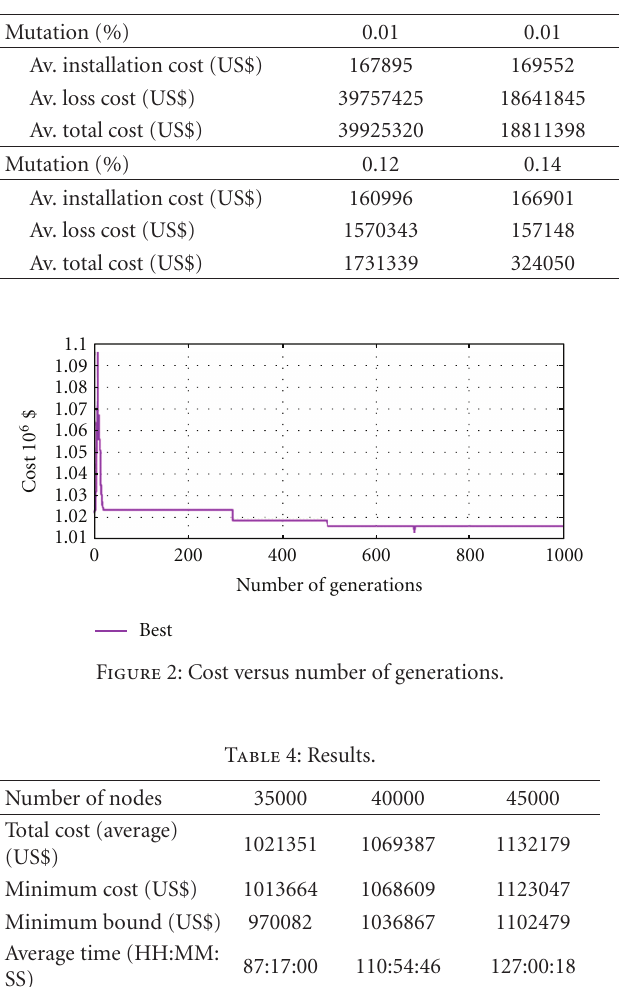
Table 3: Study of the mutation.